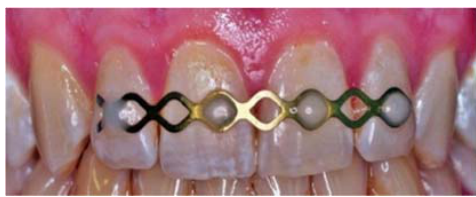
Figure 2. The titanium trauma splint.